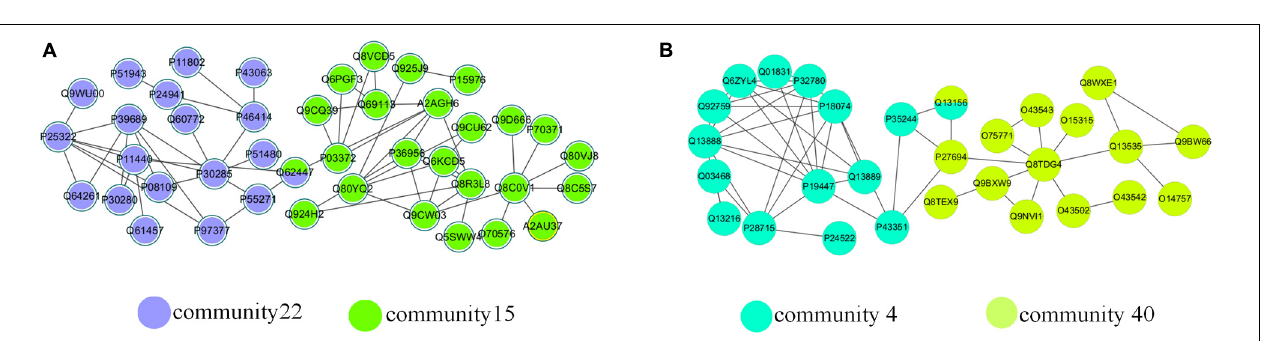
FIGURE 9 | The enrichment analysis results of the NLC in four PPI networks: (A) M. musculus , (B) H. sapiens , (C) D. melanogaster, and (D) R. norvegicus.